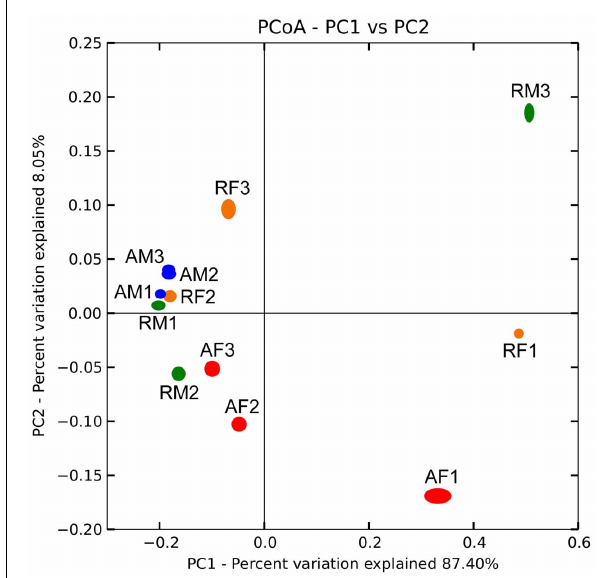
FIGURE 3 | Comparison of burkholderial communities on Sphagnum mosses in Austrian and Russian bogs by principal coordinate analysis (PCoA). PCoA biplot is based on the weighted UniFrac distance matrix of the 16S rDNA pyrosequencing libraries specific for Burkholderia and supported by 100 jackknife data re-samplings using 1781 sequences per library. The single libraries are shown by colored ellipses: blue, S. magellanicum (Austria); red, S. fallax (Austria); green, S. magellanicum (Russia); orange, S. fallax (Russia). Letters and arabic numerals specify library names. Variation explained by each principal coordinate (PC) is defined on the biplot, respectively.